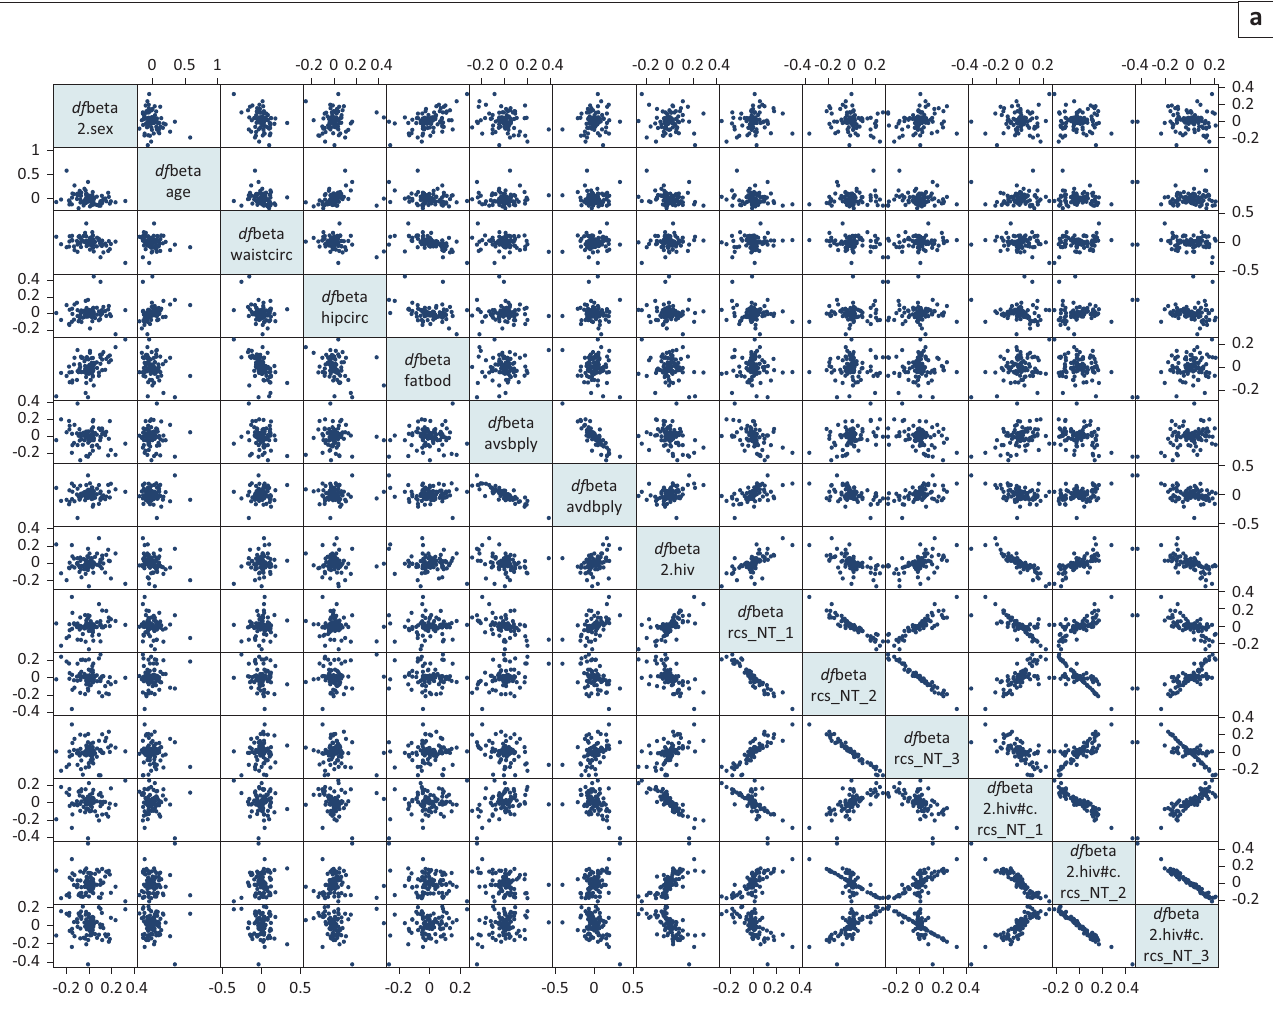
FIGURE 1-A1: Scatter plot matrix of data showing all possible plots for specified variables with df beta for linear